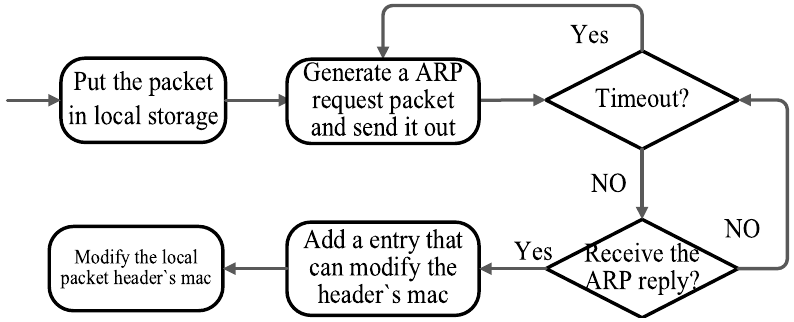
Figure 5. L3 module for the inter-domain network. Before the packet is routed in gateway and can’t get the destination mac, L3 module will send the ARP request to get the destination mac and generate a new entry to avoid triggering the ARP again.